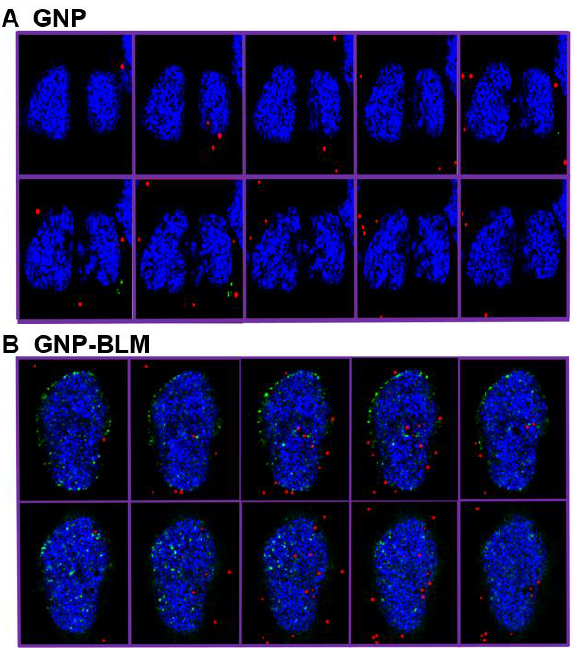
Figure 8. Hyperspectral mapping of GNP distribution and DNA DSBs in cells incubated with as-made GNPs ( A ) and GNP-BLM ( B ).( A ) Different planes across the nuclei of the cells showed that there is localization of GNPs within the nucleus when they were conjugated with drug, bleomycin. ( B ) The cells incubated with citrate capped (as-made) GNPs could not reach the nucleus.